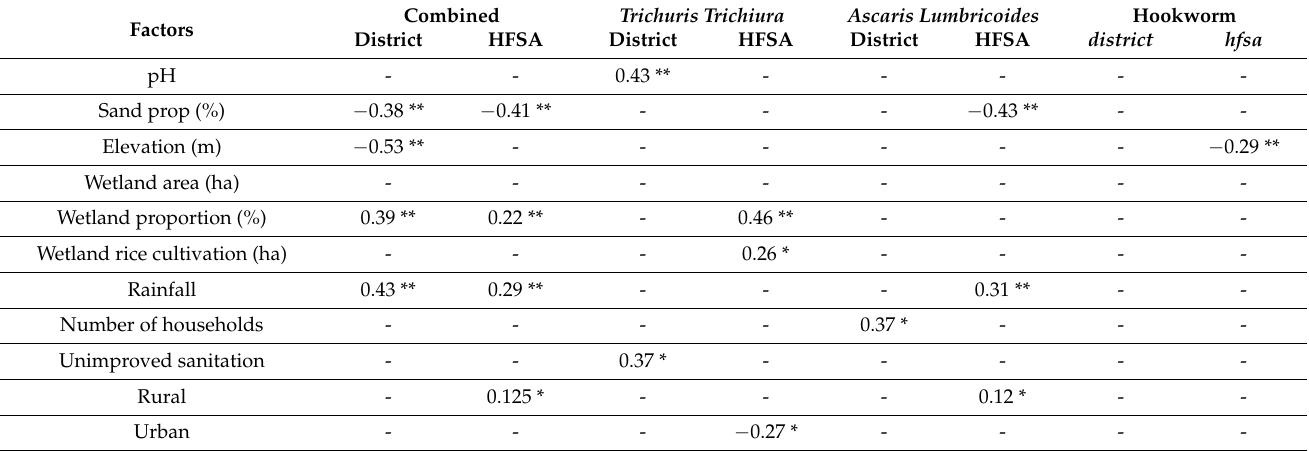
Table 3. Standardized beta coefficients of associated factors at District and HFSA spatial scale.